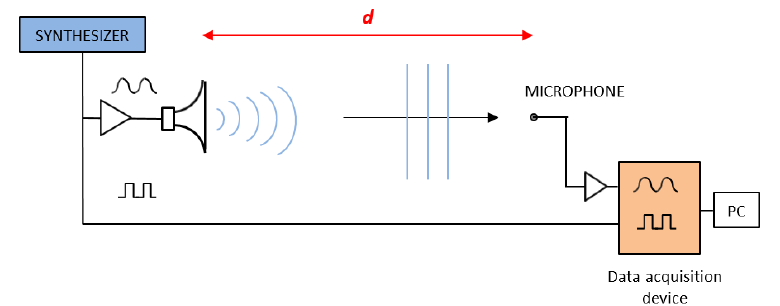
Figure 1. Principle of the experiment.